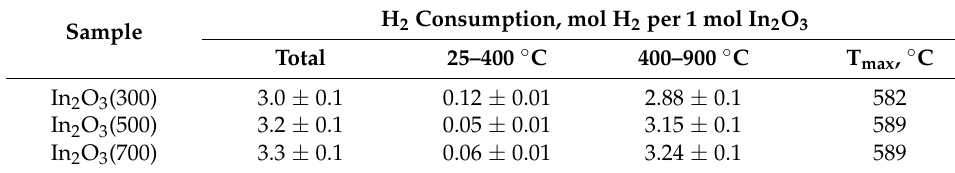
Table 3. The results of the TPR-H 2 experiments.